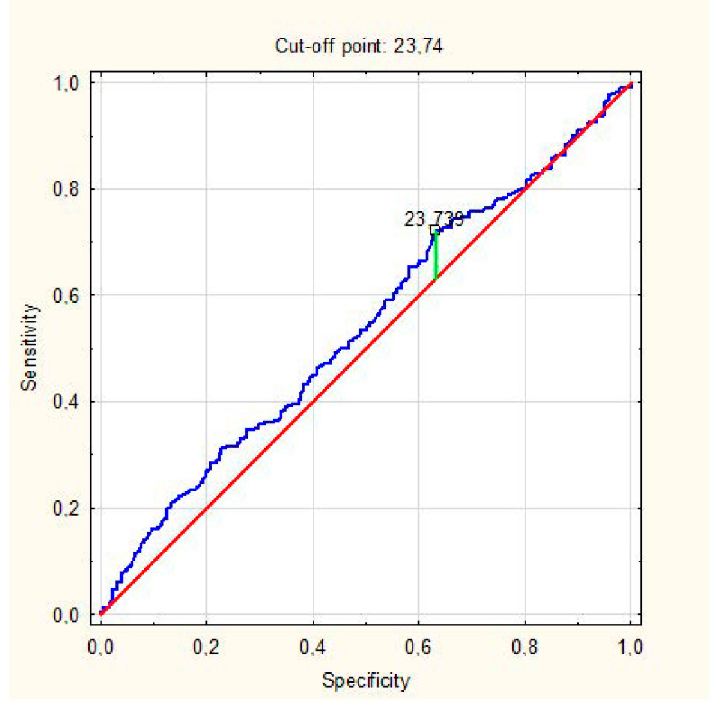
Figure 1. ROC analysis for the prediction of LC development by BMI. AUC = 0.541 (0.492–0.589), p = 0.099.